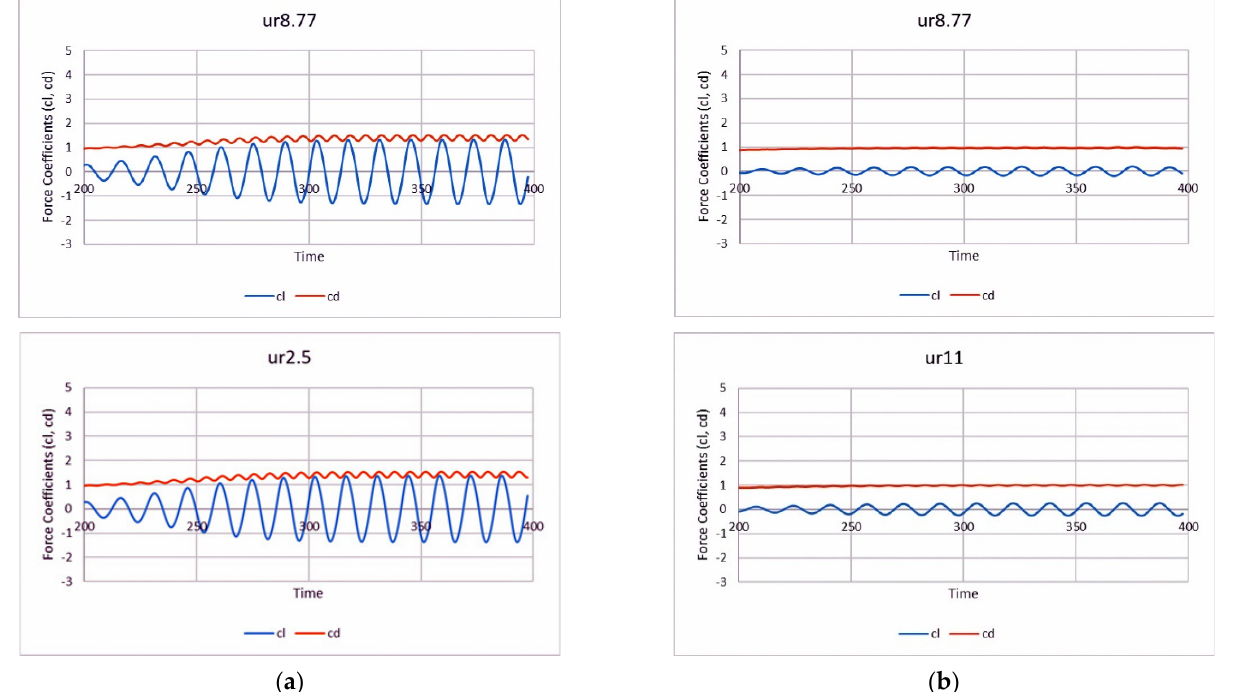
Figure 4. Force coefficients (cd & cl) at different reduced velocities with mass ratio ( a ) m* = 11 and ( b ) m* = 2.4.